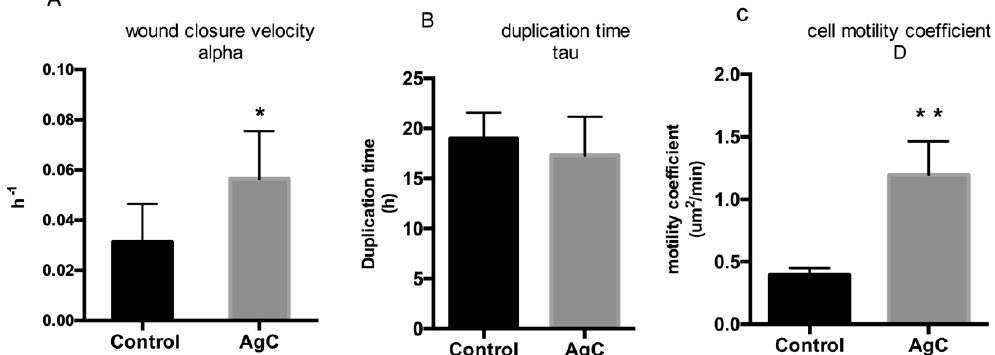
Figure 4. Effect of AgC on wound closure dynamics. Values of α (wound closure velocity) ( A ), τ duplication time) ( B ), and D (cell motility coefficient) ( C ) of the control and AgC treated cells are reported. Values of D were calculated according to the Fisher – Kolmogoroff equation from values of α and τ (see Materials and Methods). Data are expressed as the mean of at least three independent